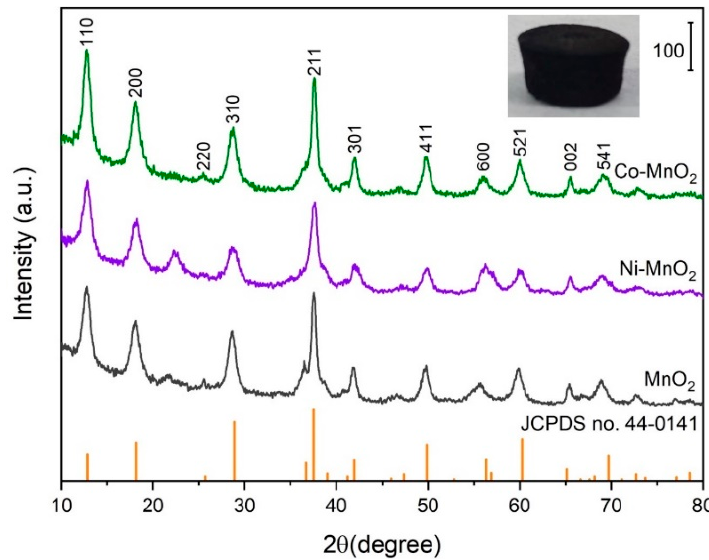
Figure 2. The X-ray diffractometer (XRD) patterns of pristine MnO 2 , Ni-MnO 2 , and Co-MnO 2 samples. The inset is the appearance of the macroscopic self-standing MnO 2 architecture.